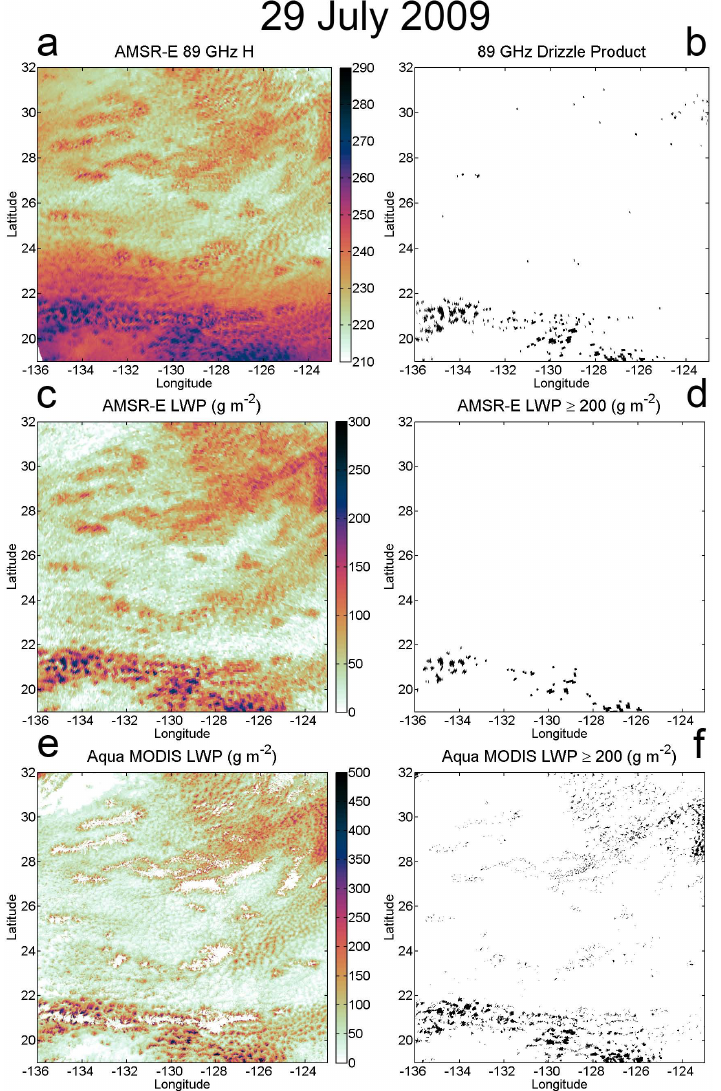
Fig. 7. Drizzle information for the northeast Pacific on 29 July 2009 at ≈ 22:00UTC. (a) is AMSR-E horizontally polarized 89-GHz bright- ness temperature from the L2A brightness temperature product. (c) is AMSR-E LWP from the L2 Ocean product. (e) is the Aqua MODIS daytime mean cloud water path from the MYD06 L2 product. (b) is the 89-GHz–based binary heavy drizzle classification field where black indicates drizzle. (d) is a binary field where black indicates AMSR-E LWP ≥ 200gm − 2 . (f) is a binary field where black indicates MODIS LWP ≥ 200gm − 2